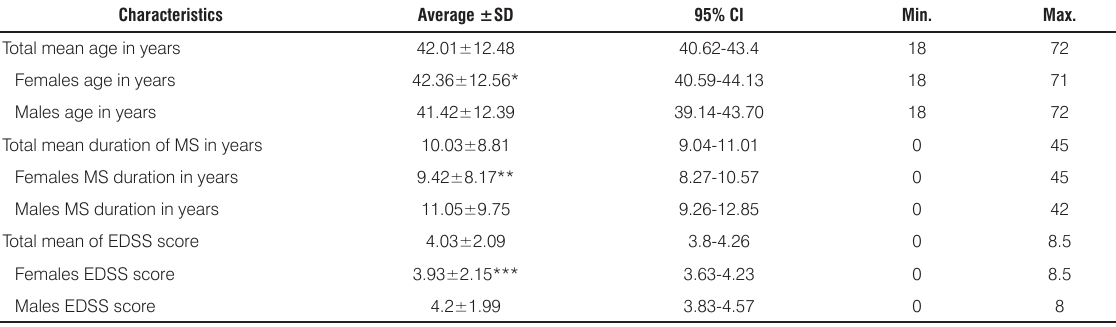
Table 1. Patient characteristics: age, MS duration and EDSS score.